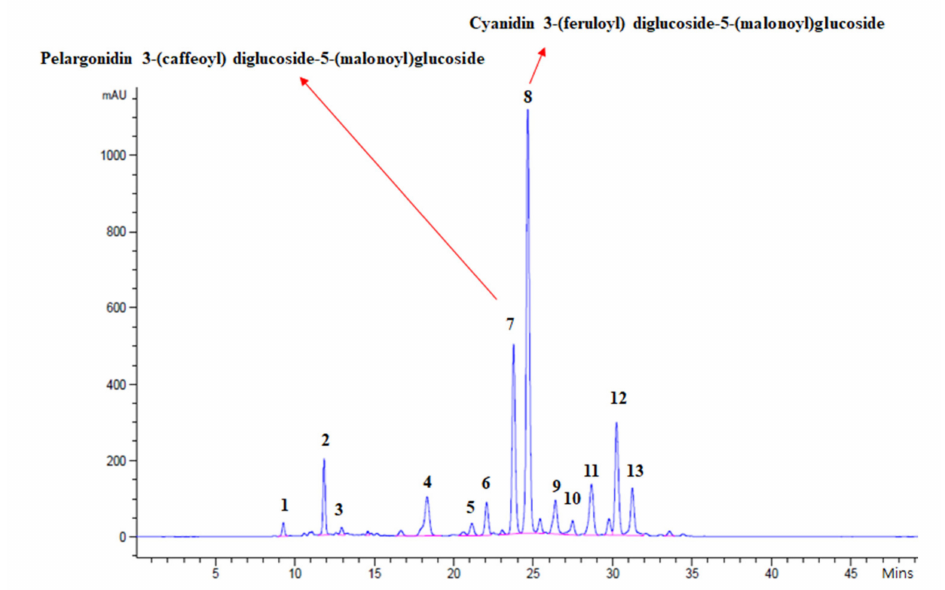
Figure 1. HPLC chromatogram of anthocyanin pigments detected in leaf extract of reddish purple Chinese cabbage at 520 nm. Horizontal axis shows retention time (min); vertical axis indicates strength of the peak